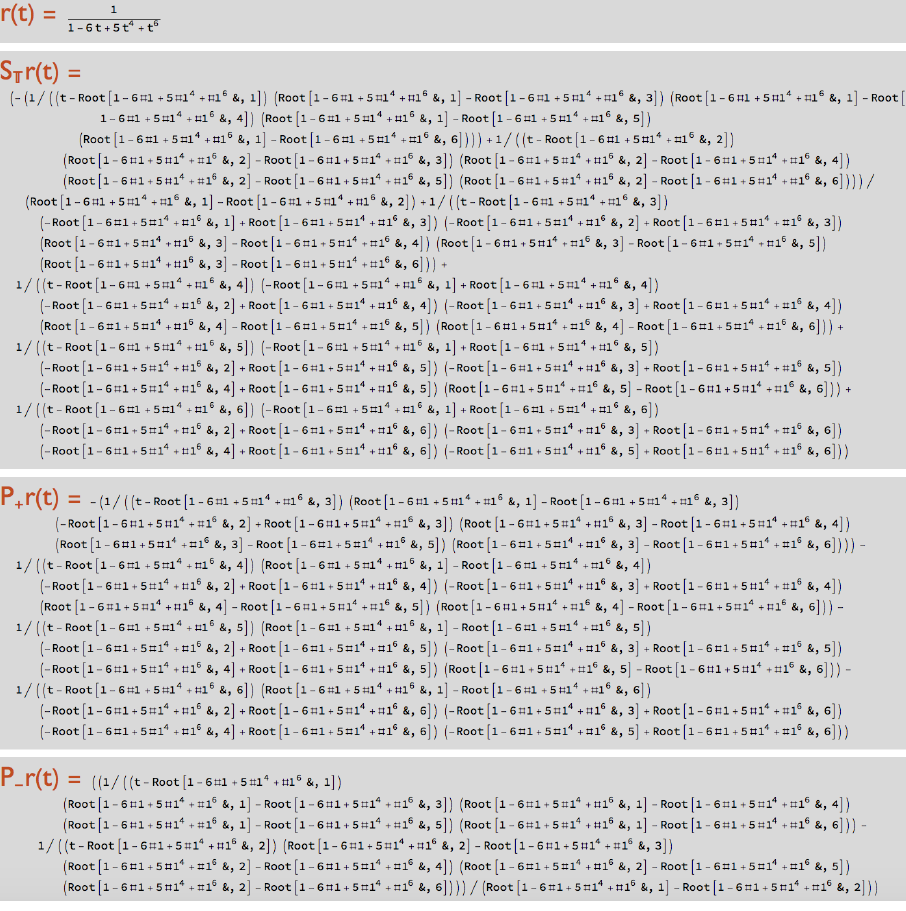
Figure 54. Output given by the [ASPPlusPMinus]